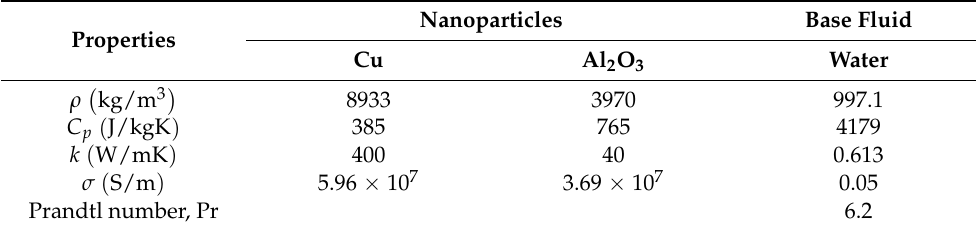
Table 1. Thermophysical properties of nanoparticles and water. Properties